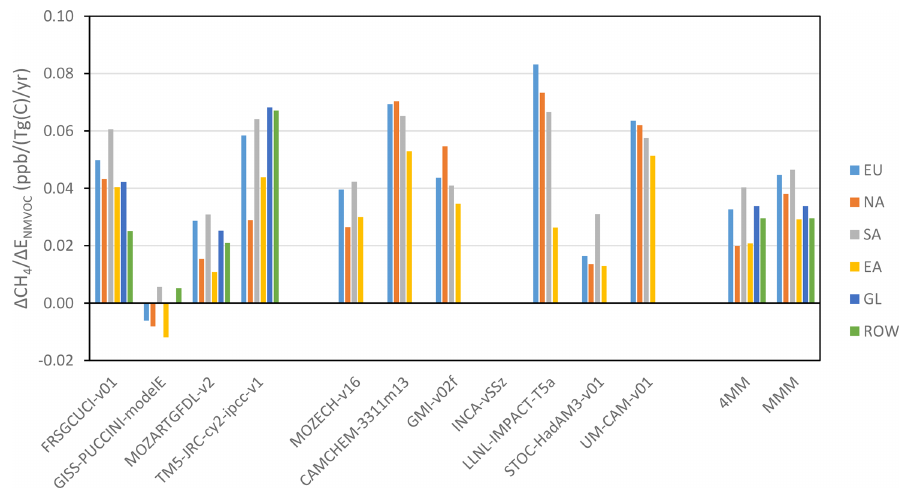
Figure 4. As in Fig. 2 but showing methane sensitivities for changes in surface anthropogenic NMVOC emissions (Tg(C)yr − 1 ). There are no results for the INCA-vSSz model for